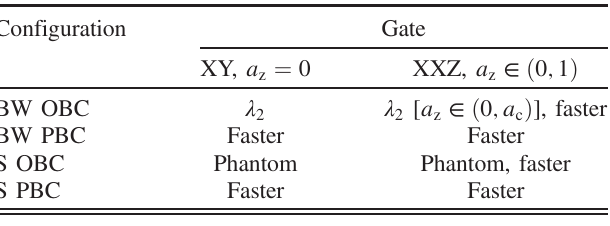
TABLE III. Origin of the entanglement rate. “ Phantom ” denotes a phantom eigenvalue resulting in a slower entanglement generation than given by j λ 2 j , “ faster ” denotes cases with faster generation than given by j λ 2 j , and λ 2 is for the one case where the rate is actually determined by j λ 2 j